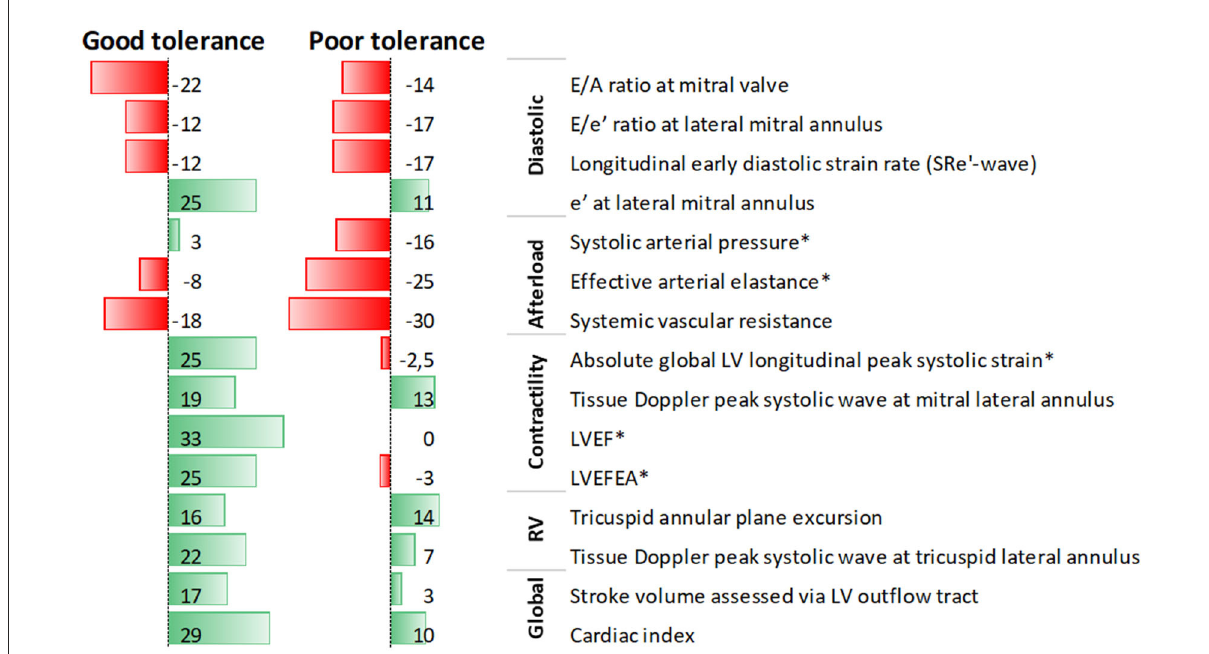
FIGURE1 Data bars of median values of percent change in echocardiographic parameters after low-dose dobutamine infusion in septic shock patients with septic myocardial dysfunction, according to tolerance to dobutamine; *denotes significant difference between patients with good and poor